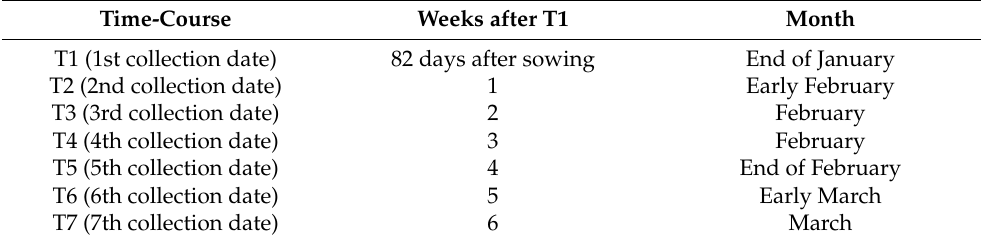
Table 2. Leaf collection schedule implemented during the time-course experiment to establish the expression profile of the TdDRF1